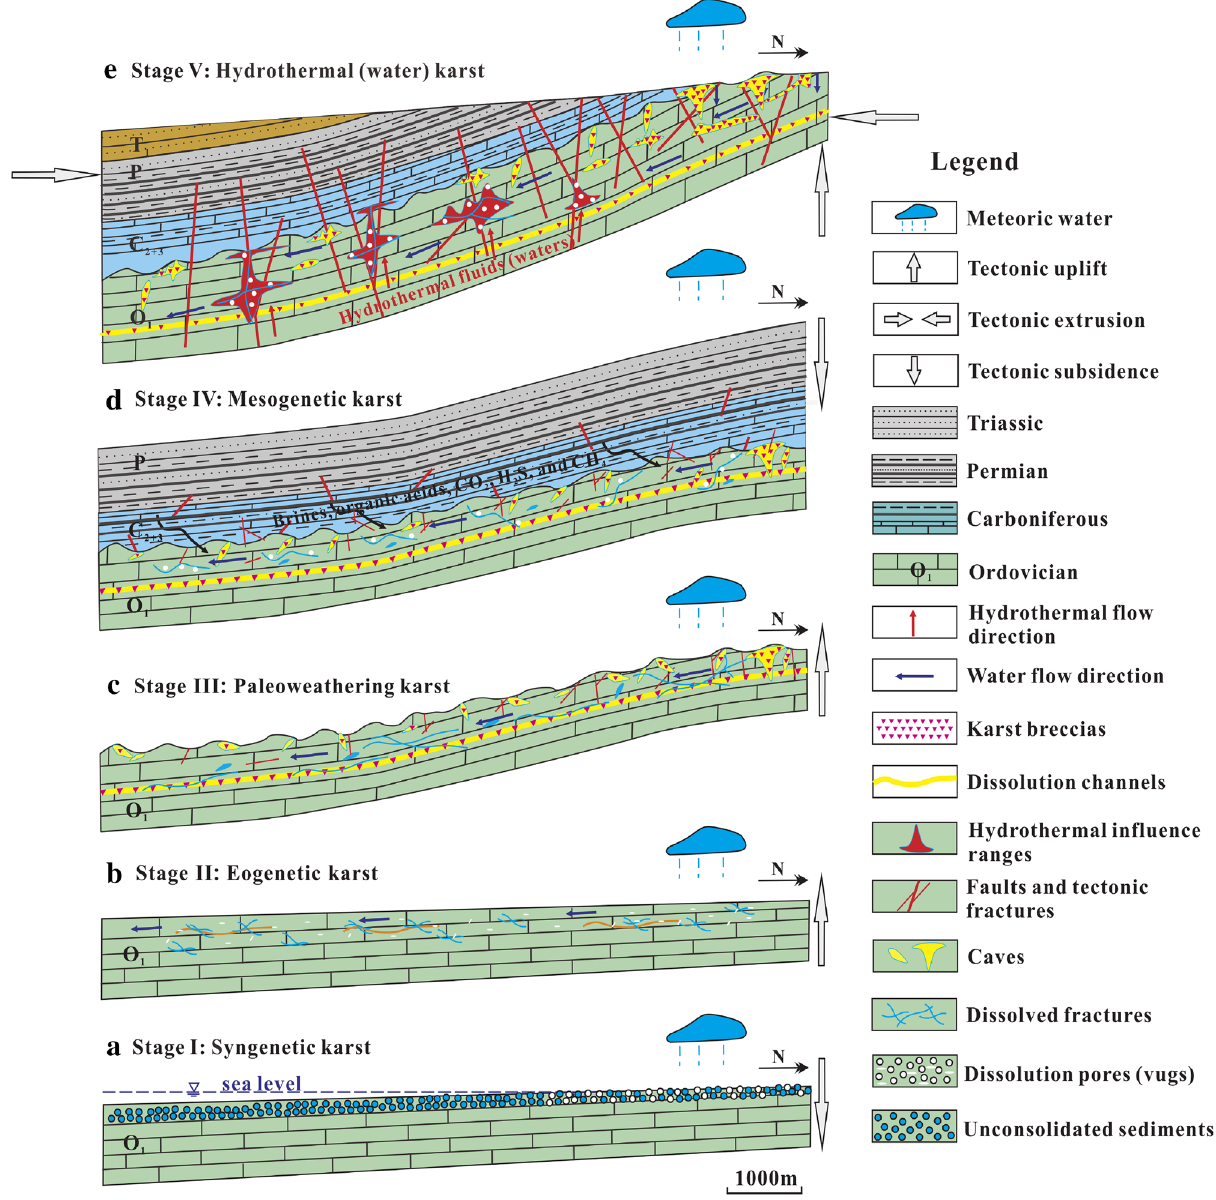
Figure 15. Evolution model of the Ordovician paleokarst in the Southern North China Basin: ( a ) Syngenetic karst formation stage; ( b ) Eogenetic karst formation stage; ( c ) Paleoweathering karst formation stage; ( d ) Mesogenetic karst formation stage; ( e ) Hydrothermal (water) karst formation stage. Maps created by the authors with CorelDRAW Graphics Suite X7 (https ://www.corel Many high-angle fractures (Fig. 7a), vugs (Fig. 3a,d,e,f), caves (Fig. 7a), and channels (Fig. 6a,b) were formed within 0 – 30 m below the Ordovician unconformities in the Huai-Fu Basin (Fig. 15c), which were partially filled with karst breccias and gray-green argillaceous muds or unfilled. Field tests showed that the porosity of the paleoweathering crust karst ranges from 5.12% to 34.16%, with an average of 22.13%, and the permeability is 102–1960 mini Darcy (mD). Therefore, the Ordovician paleoweathering crust with high porosity and high permeability is the focus of oil and gas exploration in the Huai-Fu Basin and other Basins in Northern China 54 . Stage IV : During the Permian period, the Ordovician strata entered into a relatively deep closed environment. Driven by the pressure difference, acidic materials (such as organic acids, carbon dioxide, hydrogen sulfide, meth- ane, etc.) were produced by the diagenesis of organic matter and TSR of the Permian-Carboniferous strata 15,66,67 . Such acidic materials penetrated into the underlying Ordovician carbonates and created some new pores and fractures (Fig. 15d), forming mesogenetic karst, also known as an organic acid and compacted-released water karst 8,63,64 . However, most of these new pores and fractures were almost completely filled with organic matters and/or calcites, as shown in Fig. 5f,j,k. Therefore, the mesogenetic karst may have little contribution to the Ordovician carbonate reservoirs in the Huai-Fu Basin.